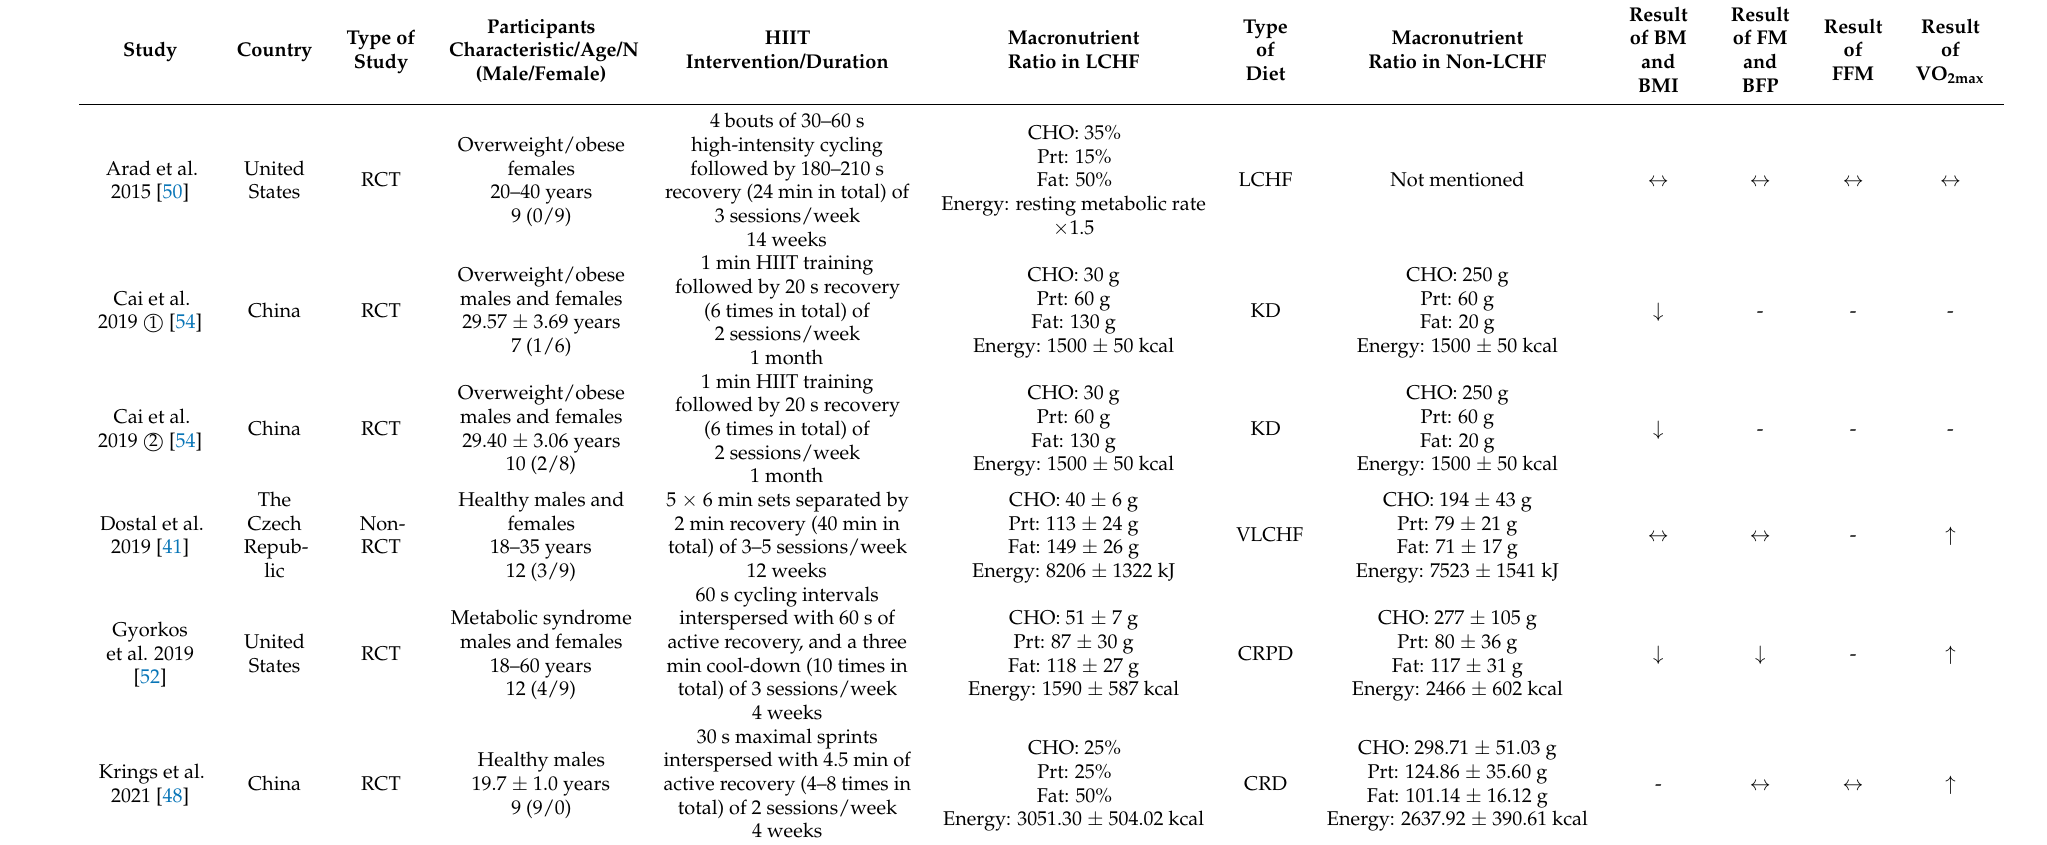
Table 1. Characteristics of studies included in the